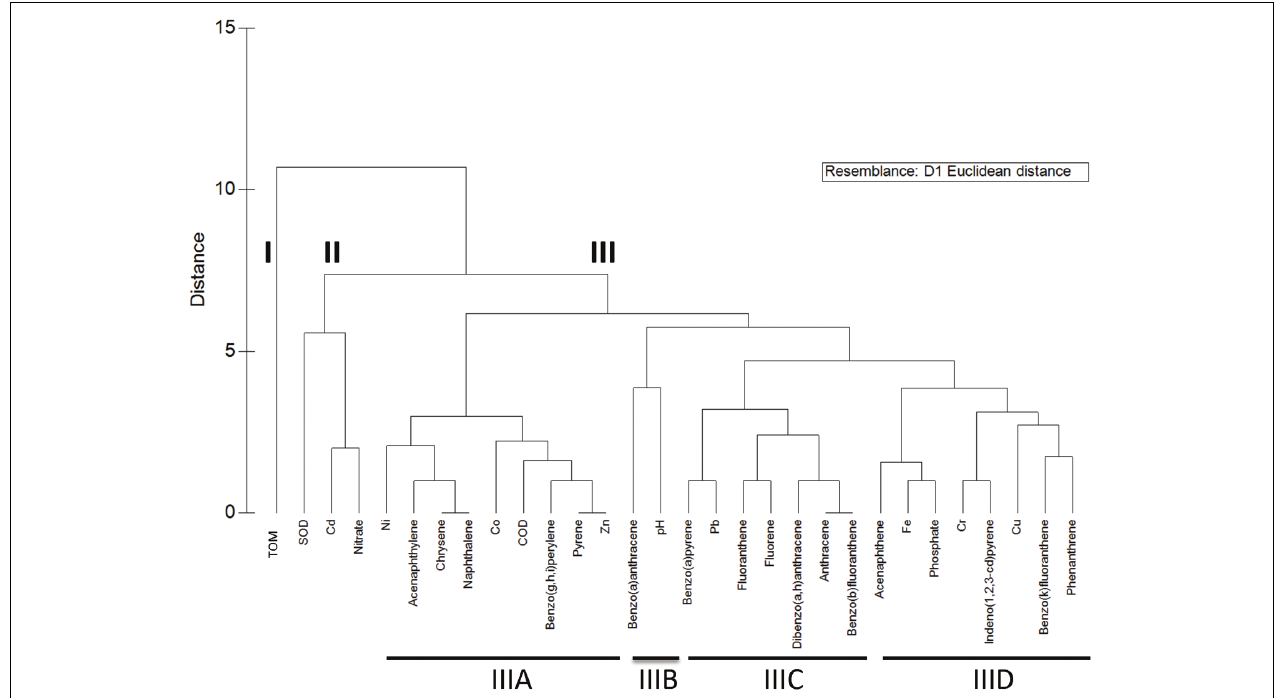
FIGURE 7 | Dendrogram illustrating groupings of environmental characteristics that frequently co-occurred as variables significantly correlated with OTU abundance. Three main branches are indicated by I-III, and four sub-branches within branch III are marked IIIA-D.